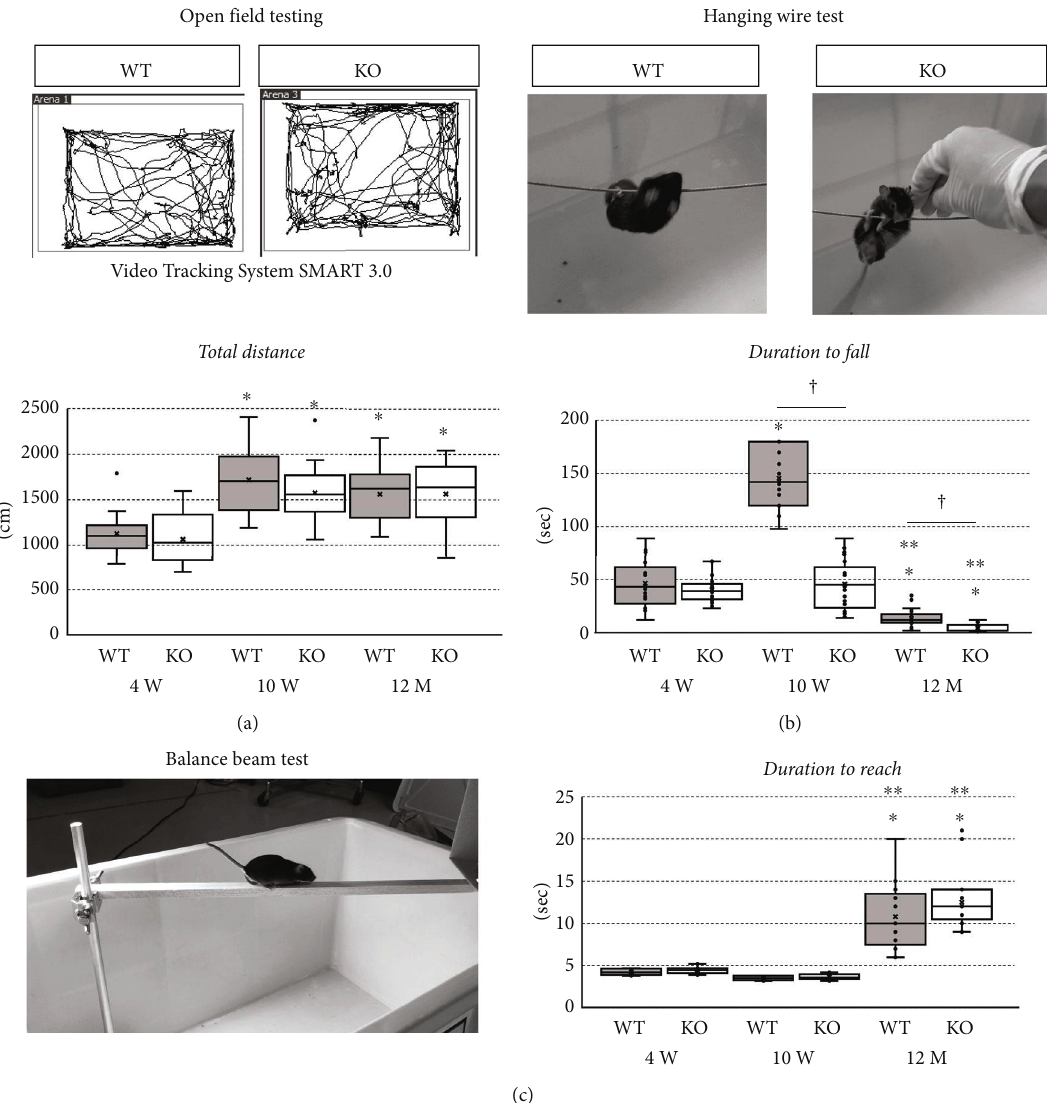
Figure 3: Behavioral assessment. Wild-type (WT) and miR-23-27-24 cluster knockout (KO), n = 8 per group. (a) Open fi eld test. Total distance travelled by the mouse in 3min was measured. In both WT and KO mice, the total distance travelled by the 10-week-old and 12-month-old mice was signi fi cantly more than the distance travelled by the 4-week-old mice. There was no signi fi cant di ff erence between WT mice and KO mice at all ages. (b) Hanging wire test. The time until the mouse fell o ff from the wire was measured (duration to fall). In both WT and KO mice, the duration to fall was signi fi cantly shorter at 12 months of age than that at 4 or 10 weeks of age. In contrast, the duration to fall at 10 weeks of age was signi fi cantly longer than that at 4 weeks of age only in WT mice. The duration to fall in KO mice was signi fi cantly shorter than that in WT mice at 10 weeks of age. ∗ Compared to 4-week-old. ∗∗ Compared to 10-week-old. † Comparison between WT and KO mice, p < 0 : 05 . (c) Balance beam test. The time taken for the mouse to cross the beam was measured (duration to reach). The duration to reach was signi fi cantly longer at 12 months of age than that at 4 or 10 weeks of age. There was no signi fi cant di ff erence between WT mice and KO mice at all ages. ∗ Compared to 4-week-old. ∗∗ Compared to 10-week- old, p < 0 : 05